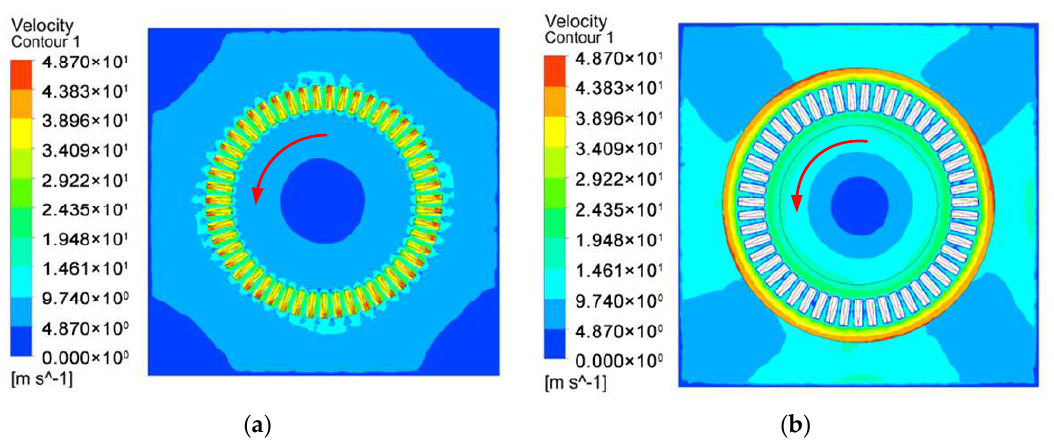
Figure 7. Velocity contours on Section 1: ( a ) without shroud; ( b ) with shroud.